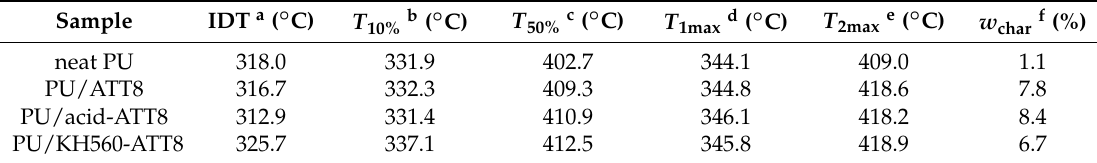
Figure 4. TGA ( a ) and DTG ( b ) curves of neat PU and PU nanocomposites containing 8 wt % ATT, acid-ATT and KH560-ATT. Table 3. TGA and DTG results for neat PU and PU nanocomposites containing 8 wt % ATT, acid-ATT and KH560-ATT.